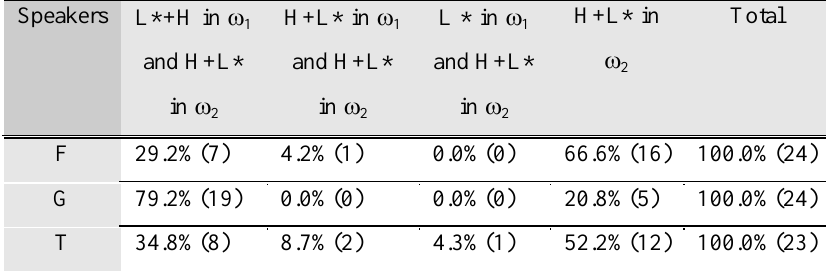
Table III. Tonal events associated with each  of the I-final branching  .